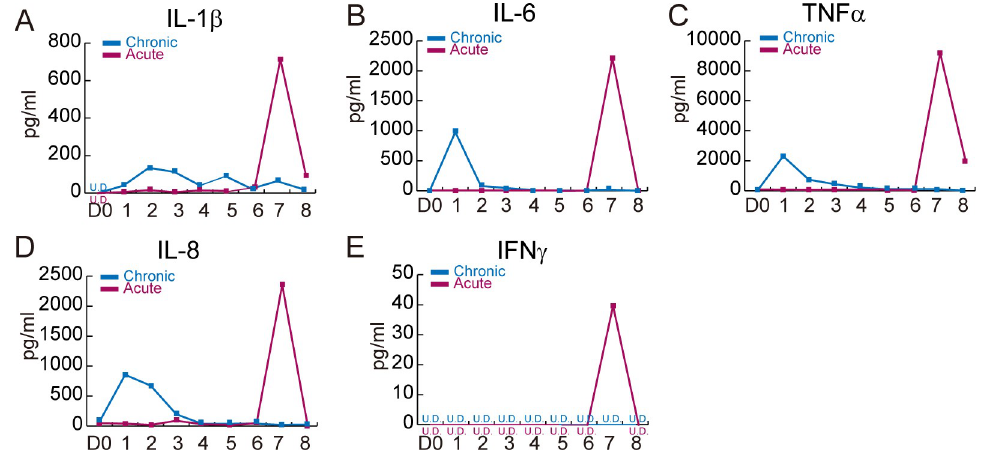
Fig 5. Serum cytokine analysis using ELISA. Blood was collected at day 0, 1, 2, 3, 4, 5, 6, 7, and 8 and then serum was isolated. Absolute cytokine levels (pg/ml) were measured by ELISA with two biological and three experimental replicates.